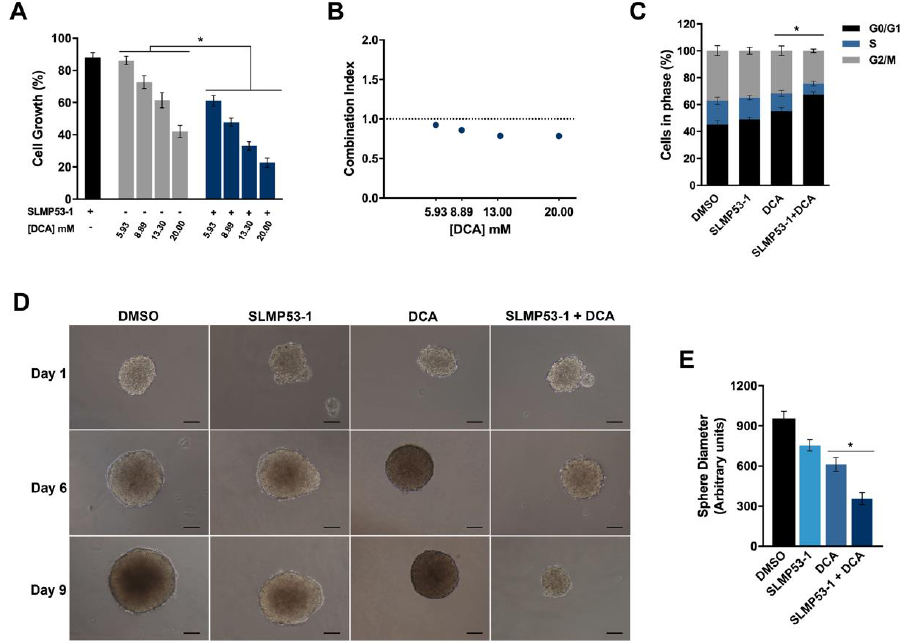
Figure 3. SLMP53-1 sensitizes cancer cells to DCA. ( A ) HCT116 cells were treated with 5.93–20